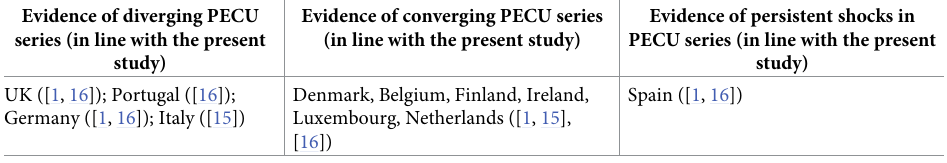
Evidence of persistent shocks in PECU series (in line with the present study)